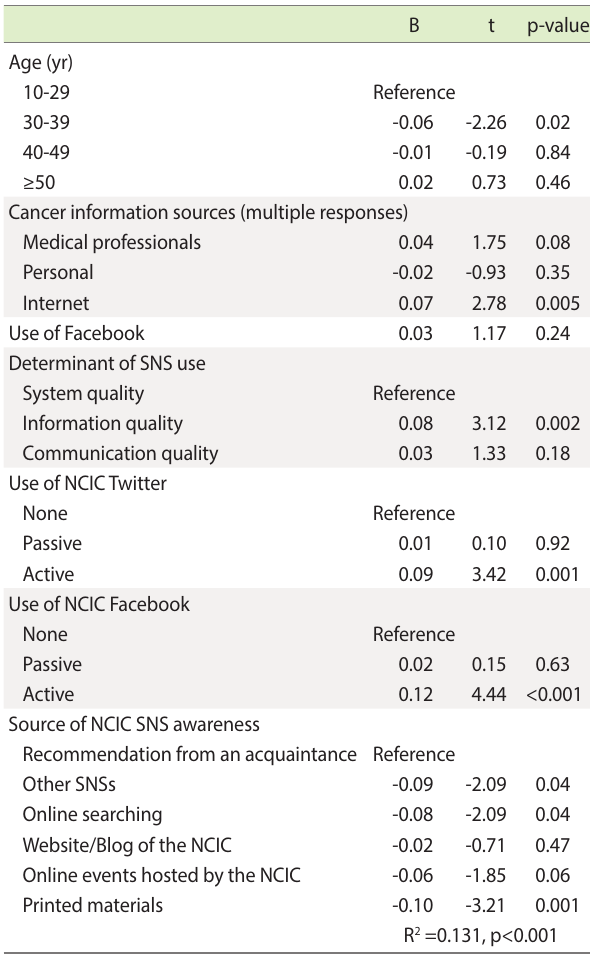
Table 3. Factors associated with satisfaction with NCIC SNSs (N=1,601)